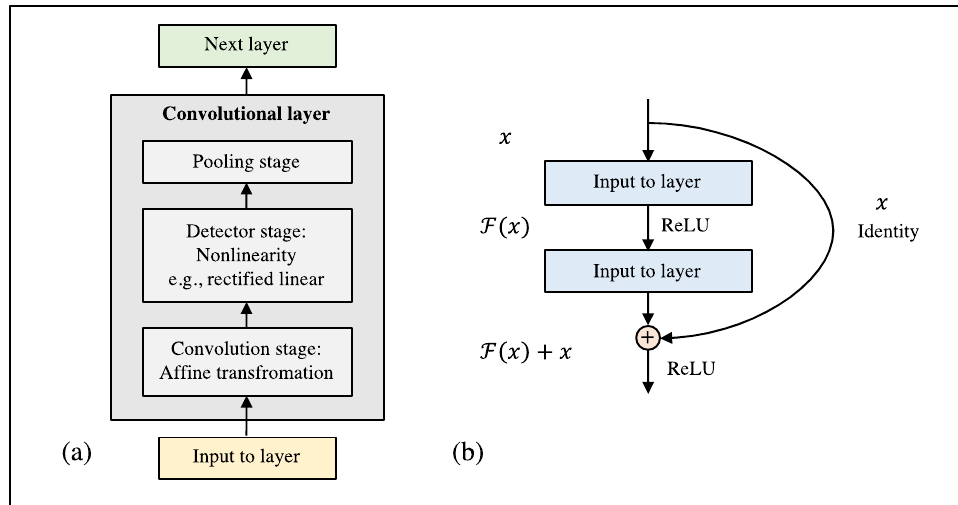
Figure 2. ResNet example: ( a ) A typical convolution layer, ( b ) example of a Residual Block [26,39].